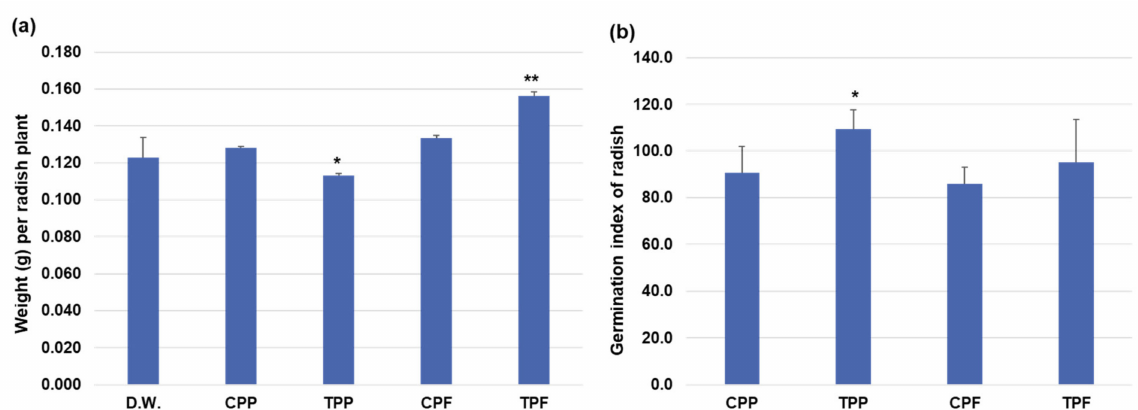
Figure 8. Inhibition effects of Streptomyces sasae St-3 on the root rot plant pathogens Pythium ultimum (KACC 40705) (TPP) and Fusarium oxysporum f. sp. lactucae (KACC 42795) (TPF), whose controls were CPP and TPP, respectively; ( a ) Weight per raddish plant, ( b ) Germination index of radish plant; * p < 0.05 and ** p <